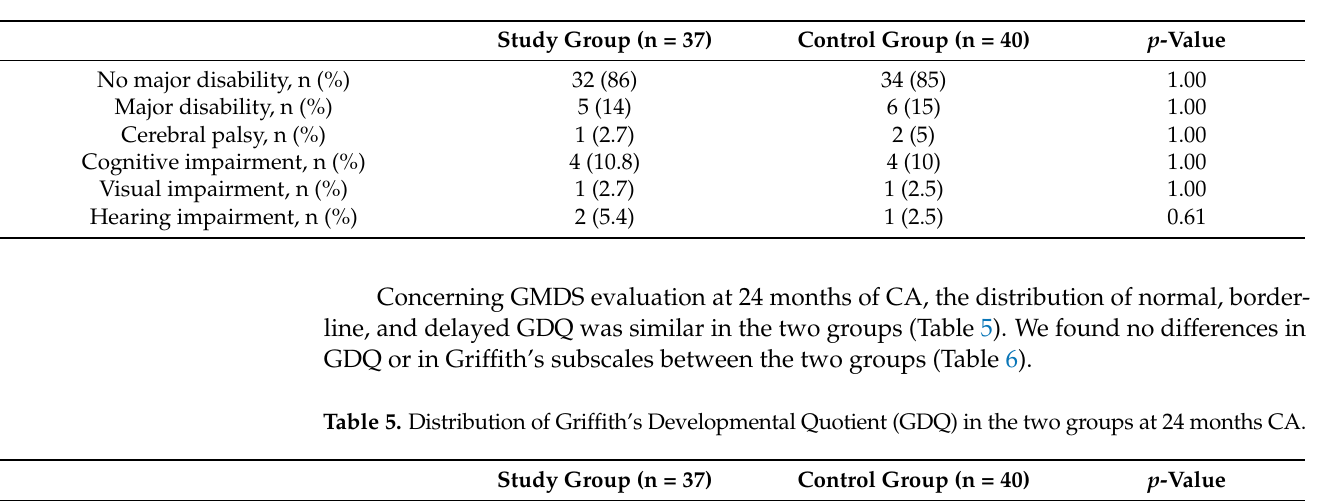
Table 4. Long-term neurodevelopmental outcomes in the two groups at 24 months CA.